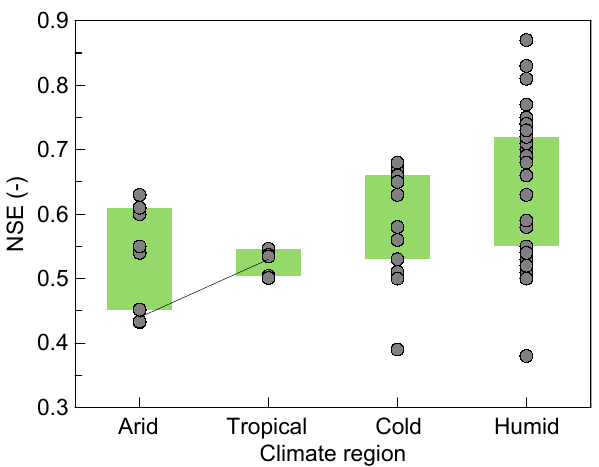
Fig. 2. Median Nash–Sutcliffe efficiency of predicting hydrographs in ungauged basins stratified by climate (Level 1 assessment). Each symbol refers to a result from the studies in Table 1. Line indicates study (Petheram et al., 2012) where the same method was applied across different climatic regions. Boxes show 25–75%